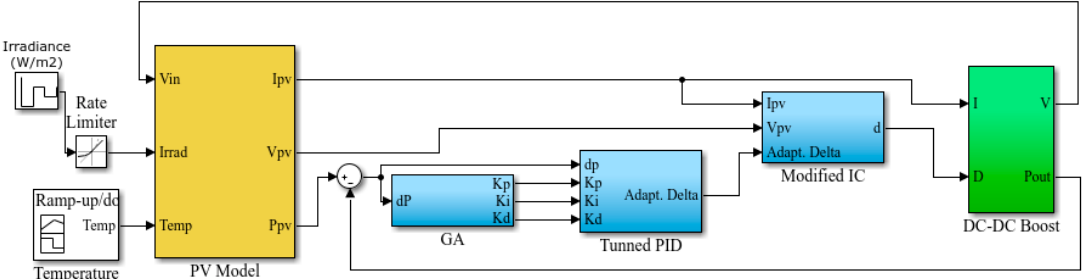
Figure 3. PV system with the proposed methodology block diagram.